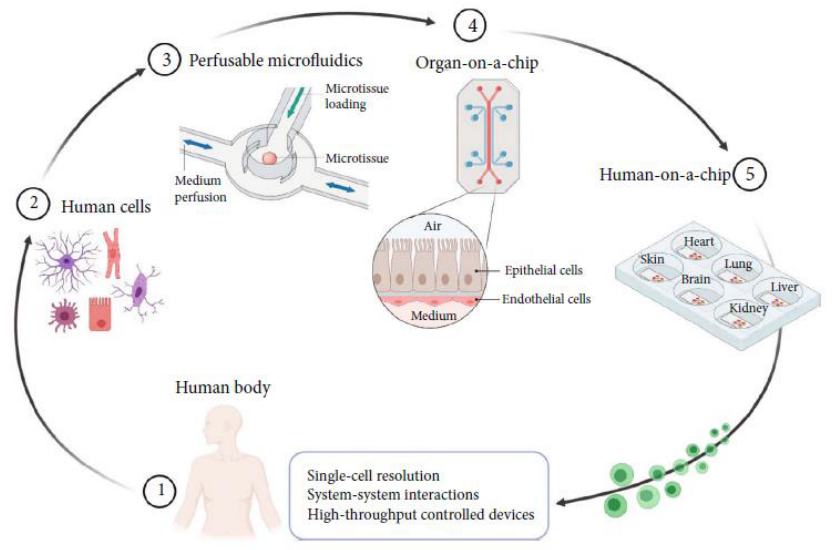
Figure 14. Extracted cells (2) from a human body (1) are placed in perfusable microfluidics (3) to construct OoCs (4). Multiple OoCs are combined in a human-on-a-chip (5) [2]. Reproduced with permission from American Association for the Advancement of Science Copyright (2023).